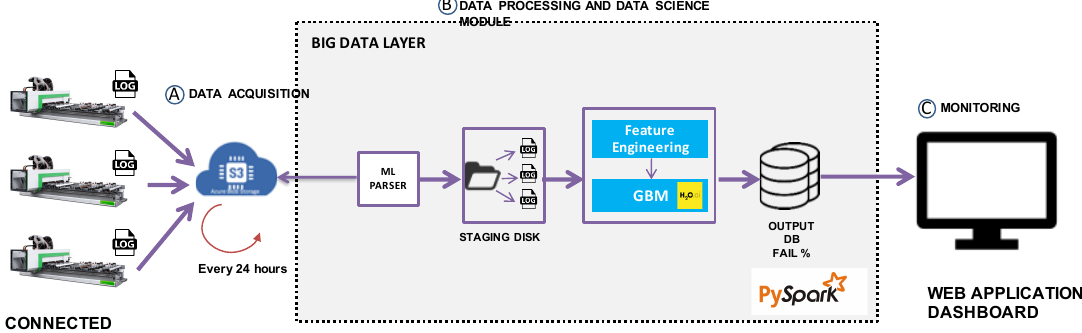
Figure 1. High-level pipeline architecture. The pipeline architecture illustrates the architecture that characterizes the Predictive Maintenance (PdM) application. ( A ) Data acquisition step is performed through Azure Blob storage service. ( B ) Apache Spark is used for data preprocessing, parsing of log files and predictive modeling. ( C ) The predicted probabilities of machine down are visualized by a dedicated dashboard to evidence the trend of connected